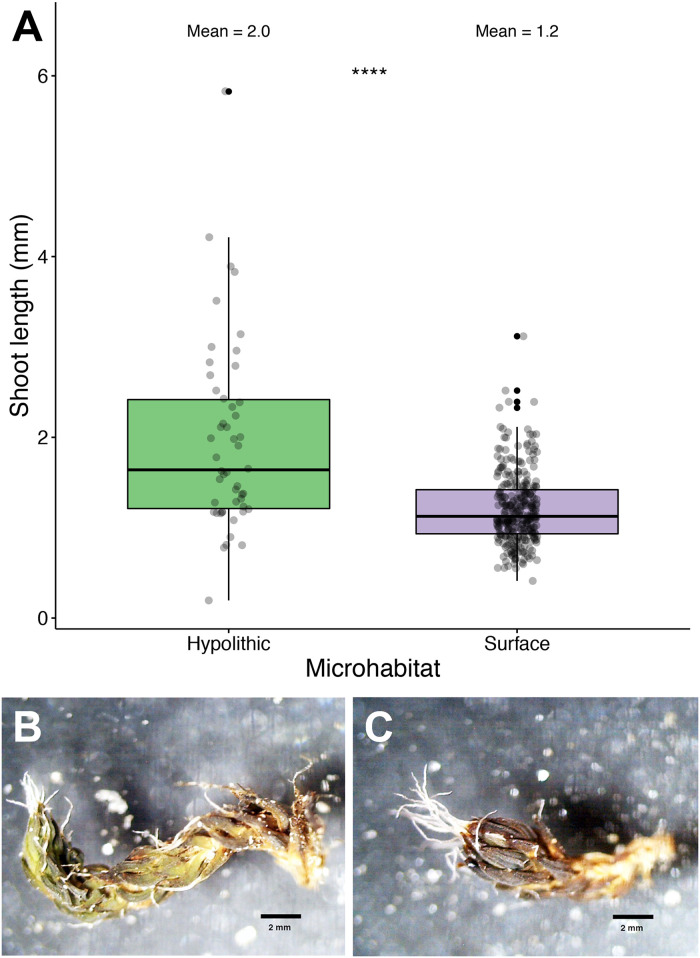
Differential shoot length in Syntrichia caninervis shoots from hypolithic and soil surface microhabitats.(A) Box plot of hypolithic and soil surface S. caninervis shoot length. **** Wilcoxon test, P < 0.0001. MeanHYP = 2.0 mm, meanSUR = 1.2 mm; nHYP = 50, nSUR = 299. (B) An S. caninervis shoot from a soil surface microhabitat. (C) An S. caninervis shoot from a hypolithic microhabitat.